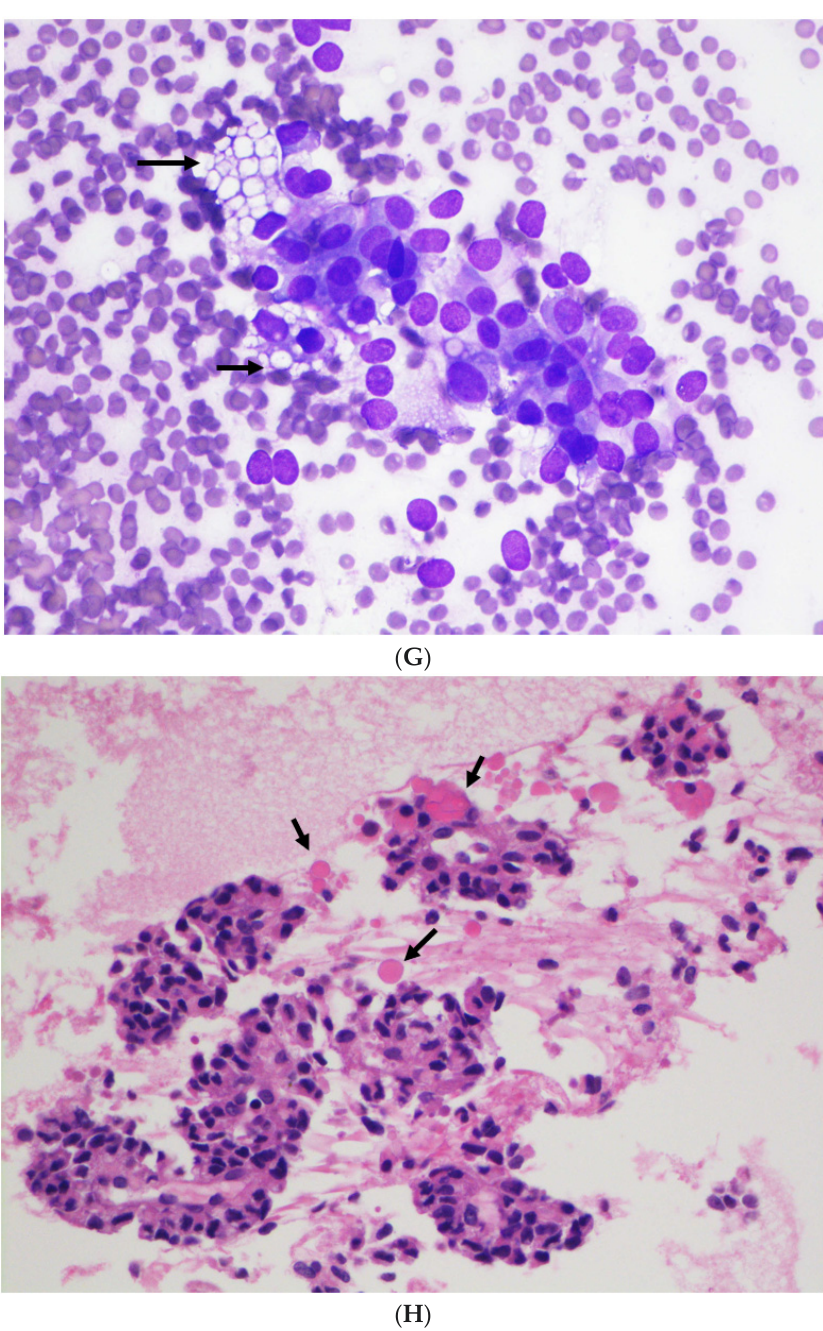
Figure 1. ( A ) Cellular aspirate with branching pseudopapillary fragments in a straight line, L shape, and C shape; central delicate capillaries (black arrows) surrounded by discohesive small- to medium-sized monomorphic neoplastic cells (Case #7, EUS-FNA, Diff-Quik, original magnification ×100). ( B ) Delicate central capillary network (black arrow) and discohesive cercariform cells (red arrows) (Case #3, Papanicolaou, EUS-FNA, original magnification ×200). ( C ) Relatively uniform plasmacytoid single neoplastic cells, with some showing a cytoplasmic tail (red arrows) (“cercariform cell”) (Case #3, EUS-FNA, Diff-Quik, original magnification ×200). ( D ) Monomorphic neoplastic cells with extracellular metachromatic magenta material (black arrows). Note the foamy macrophage in the lower field (Case #3, EUS-FNA, Diff-Quik, original magnification ×400). ( E ) An extreme example of prominent extracellular metachromatic magenta material (black arrows), corresponding to the myxoid stroma seen in ( F ) (Case #6, EUS-FNA, Diff-Quik, original magnification ×200). ( F ) Solid-pseudopapillary neoplasm with prominent myxoid fibrovascular stroma (black arrow) and paranuclear vacuoles (red arrow) (Case #6, resection, H&E, original magnification ×400). ( G ) Neoplastic cells with intracytoplasmic vacuoles (black arrows) on ROSE, interpreted as